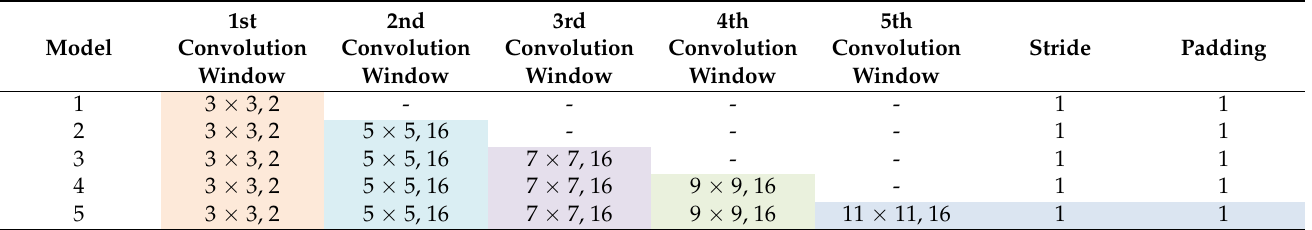
Table 3. Different convolutional layer models of the multilayer CNN-based classifier (Models #1–#5).